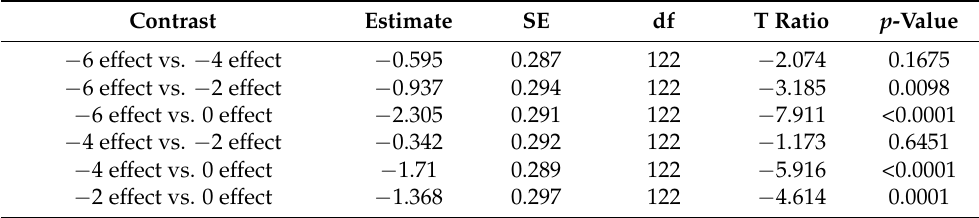
Table A2. Tukey’s pairwise post hoc comparisons for feeding experiment I; see Figure 8.